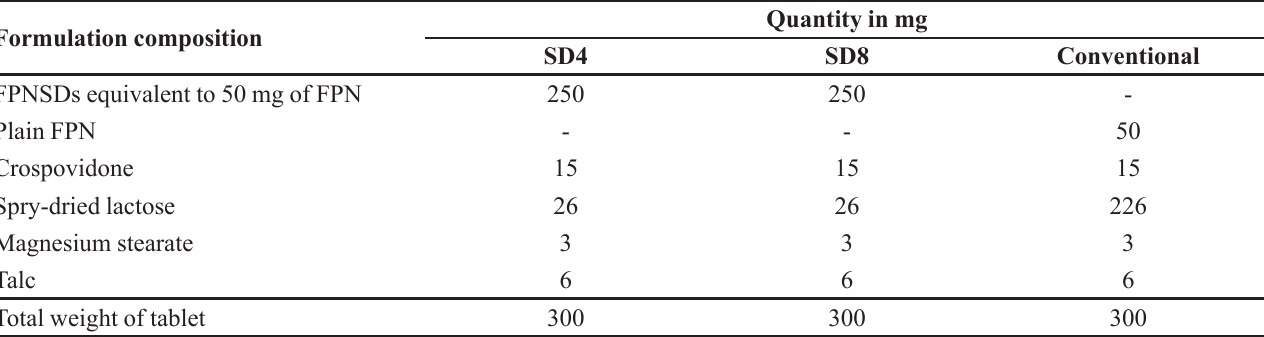
TABLE II - Composition of selected FPN SDs tablets Formulation